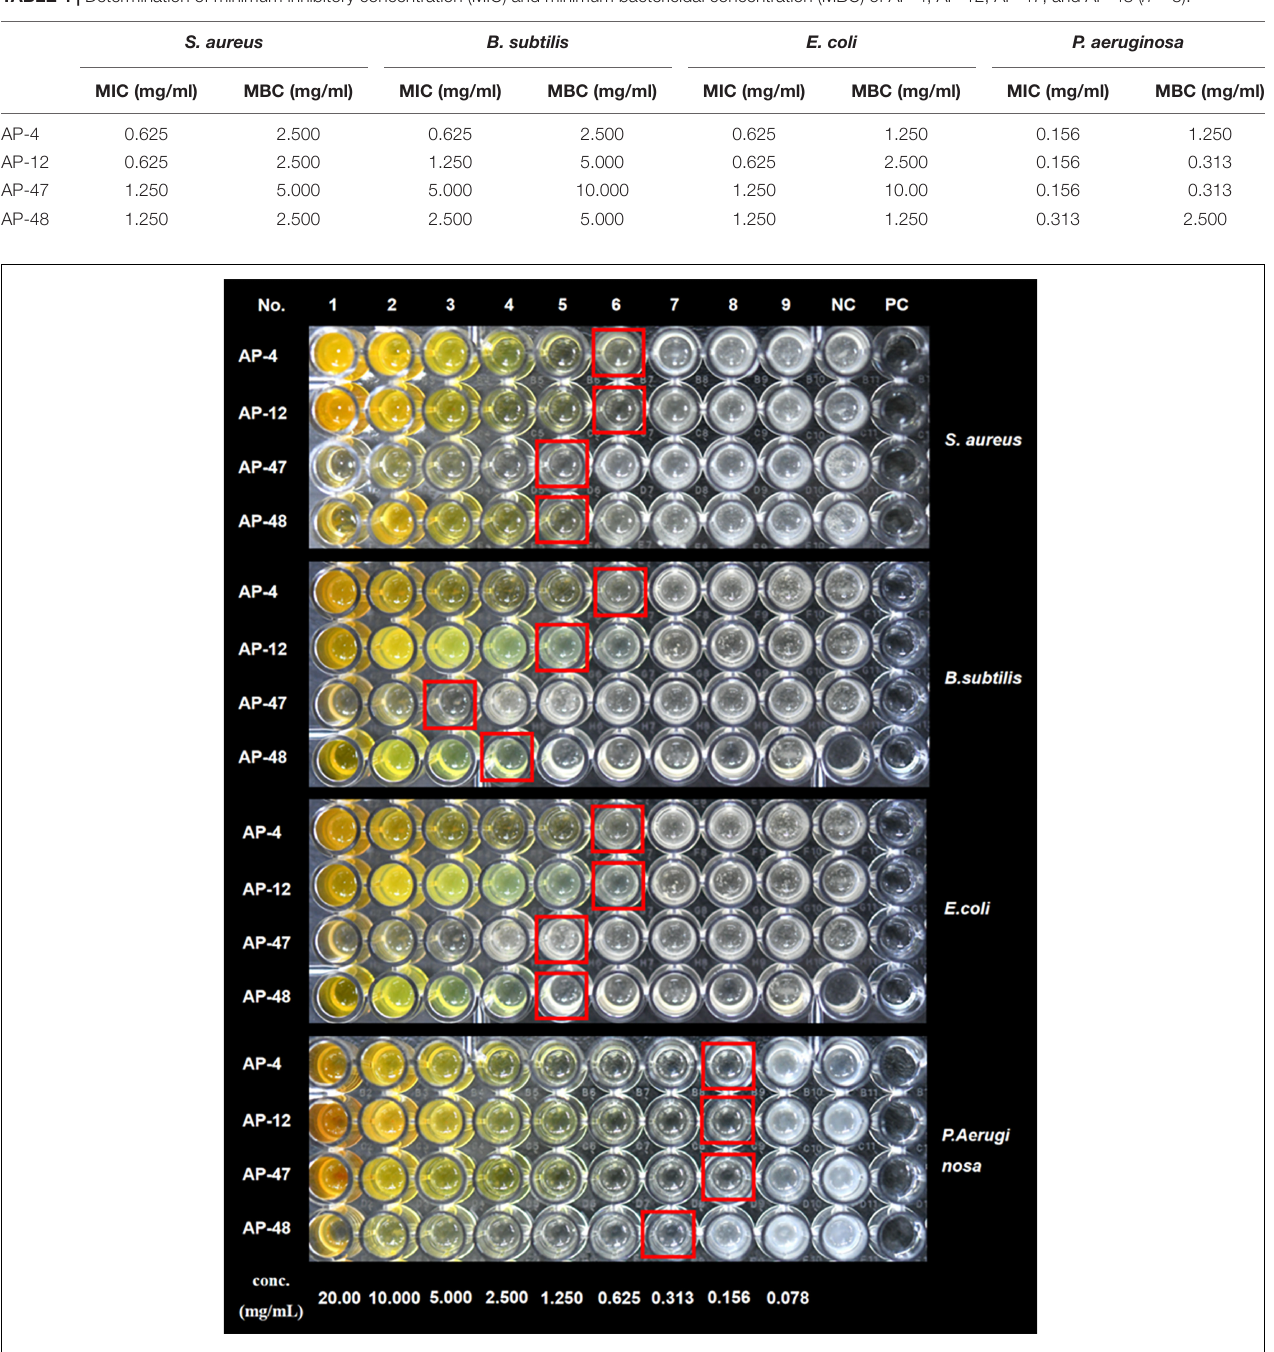
FIGURE 7 | MIC of AP-4, AP-12, AP-47, and AP-48 against S. aureus , and B. subtilis , E. coli , and P. aeruginosa .